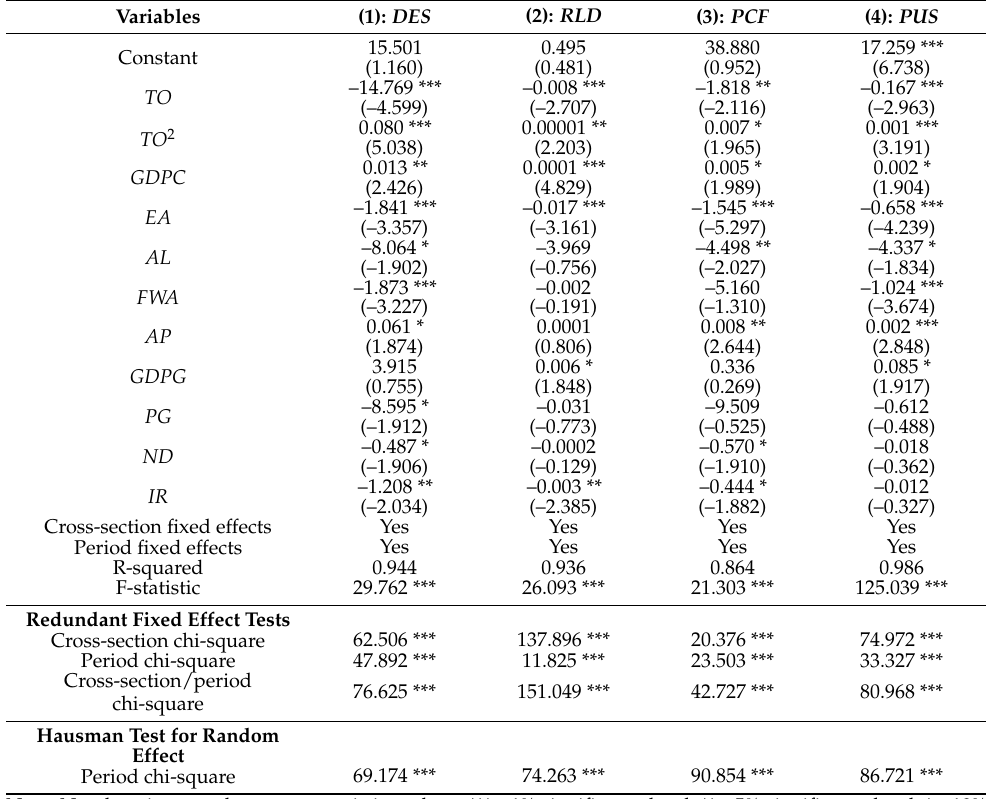
Table 5. Estimation results of panel data fixed effect